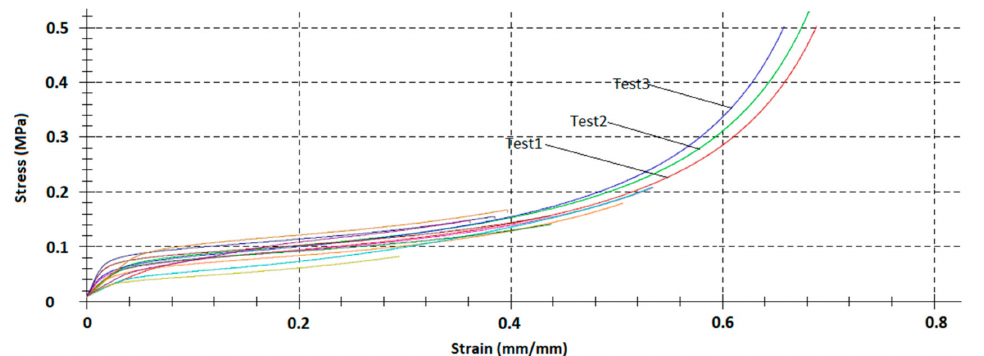
Figure 8. Varying strain rate compression tests three repeats (Tests 1–3) for low-density (20 g/dm 3 ) EPP foams, sample size 20 mm × 20 mm, 30 mm height.